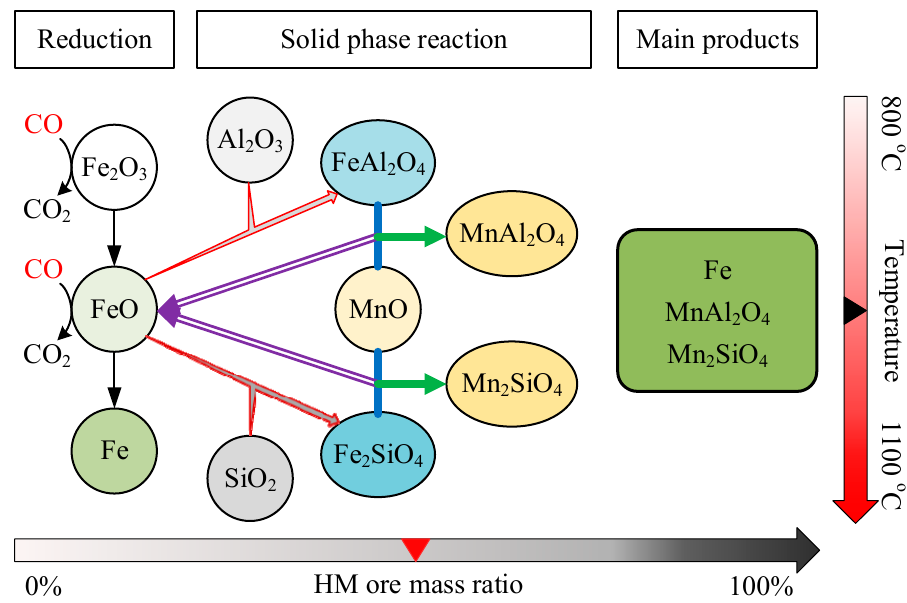
Figure 14. Thermodynamic simulation of a system consisting of Fe 2 O 3 , CO, SiO 2 , Al 2 O 3 and MnO (with different high-manganese iron ore (HM ore) ratio) carried out at 1050 °C in CO atmosphere at ambient pressure.